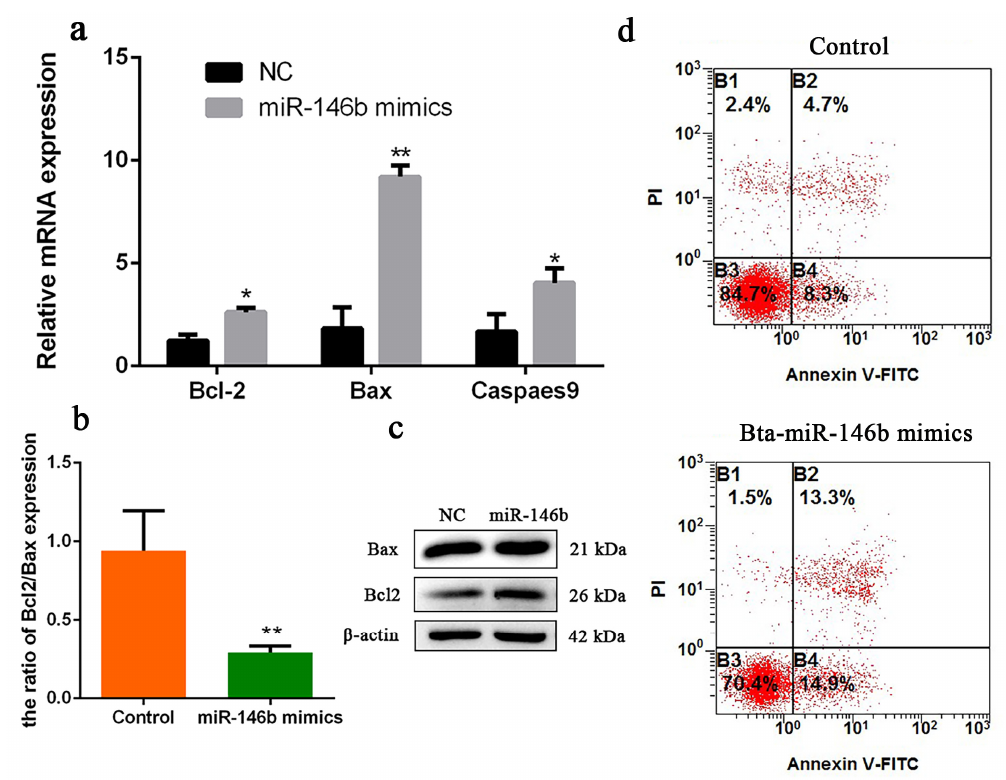
Figure 5. Bta-miR-146b regulates apoptosis of bovine male germline stem cells. ( a ) Cell apoptosis-related genes ( Bcl-2 , Bax and Caspase 9 ) mRNA expression levels were detected after overexpressing bta-miR-146b by qRT-PCR. ( b ) The ratio of Bcl-2/Bax gene expression after overexpressing bta-miR-146b. ( c ) Cell apoptosis-related genes ( Bcl-2 and Bax ) protein expression level was detected by western blot analysis after a gain of bta-miR-146b. β -Actin was used as the reference gene. ( d ) Apoptotic muscle cells were detected by annexin V-FITC/PI-staining flow cytometry after a gain of bta-miR-146b. Data are presented as mean ± SEM; * p < 0.05 and ** p < 0.01. FITC: fluorescein isothiocyanate; miR: microRNA; mRNA: messenger RNA; NC: negative control: PI: propidium iodide; qRT-PCR: quantitative real-time polymerase chain reaction.